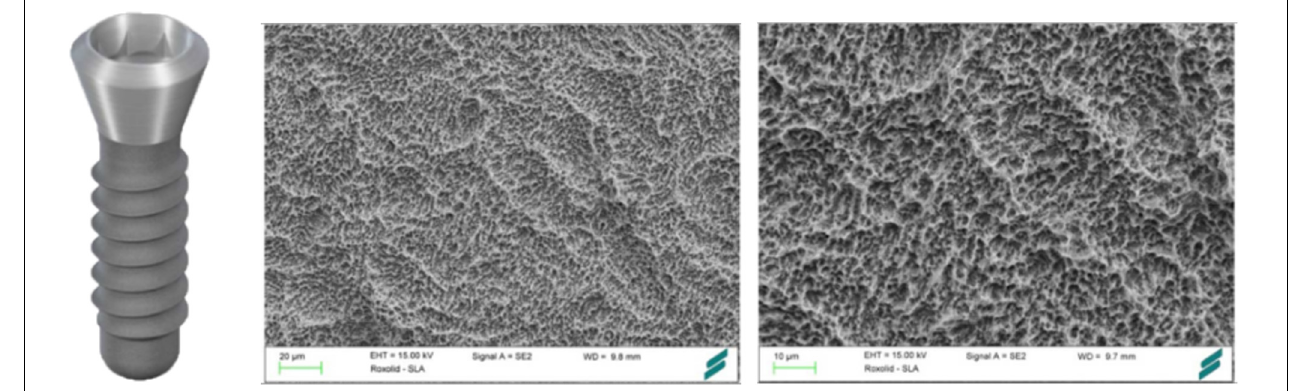
FIGURE 1 | Surface features and scanning electron micrographs of a Roxolid implant with SLA surface.